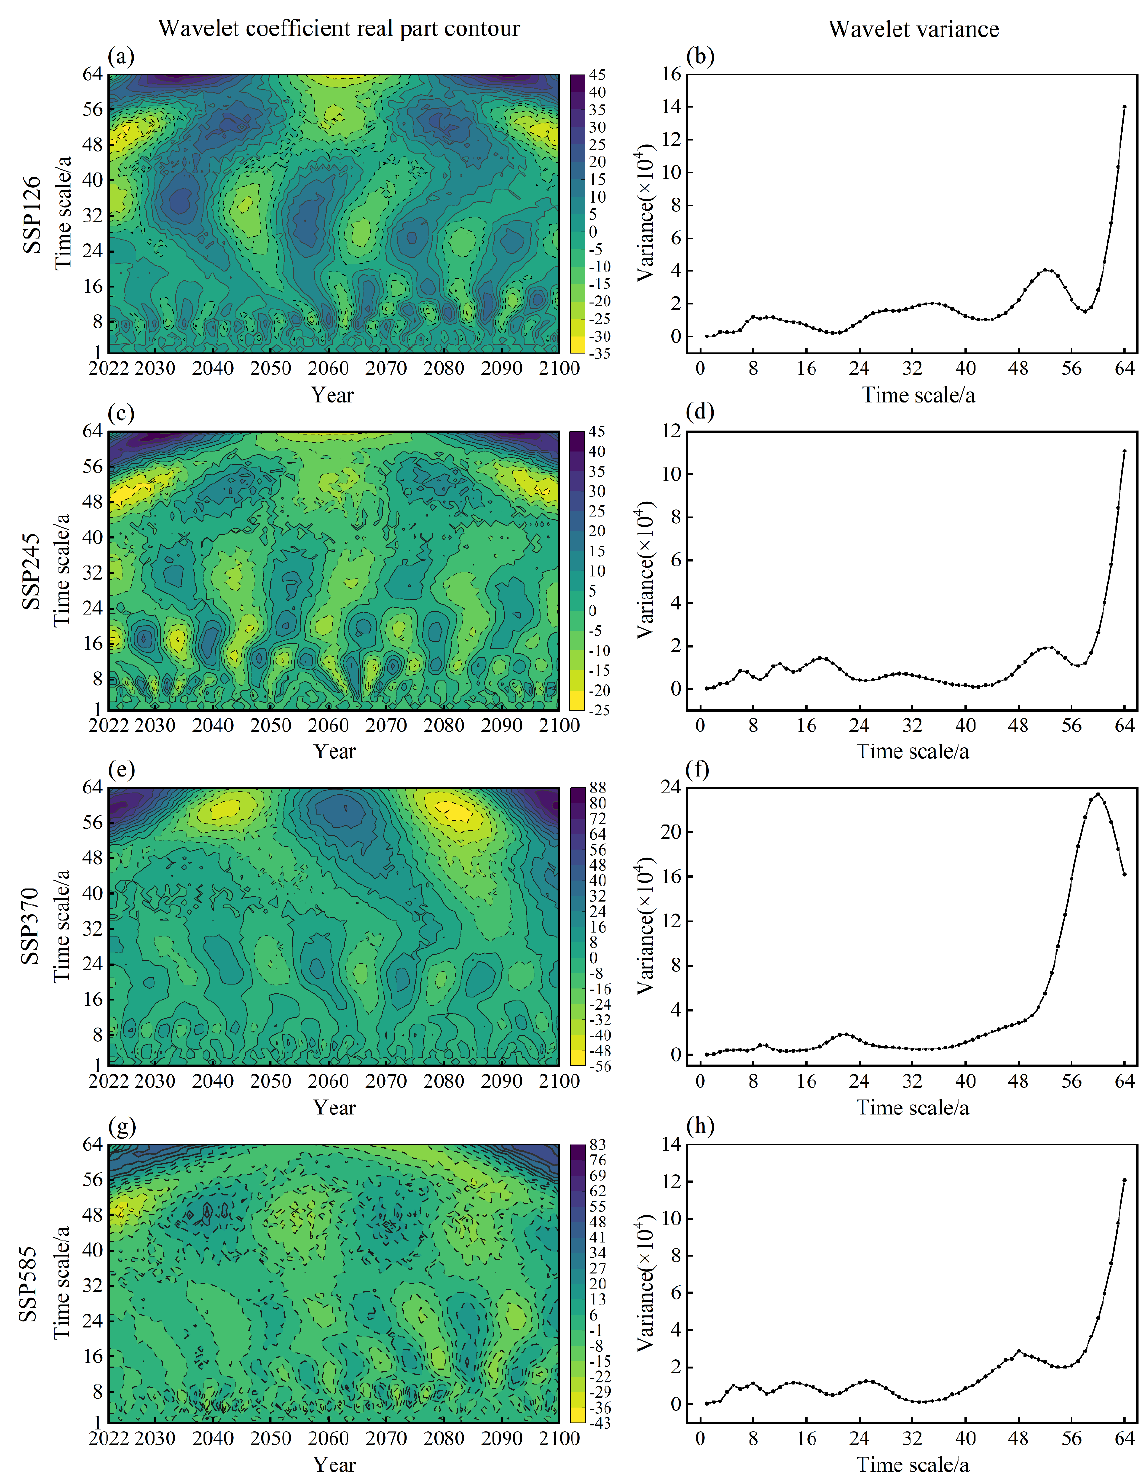
Figure 9. Wavelet analysis of ET 0 in the Yellow River Basin under four future emission scenarios (SSP126, SSP245, SSP370, and SSP585), including wavelet coefficient contour plots of the real part ( a , c , e , g ) and wavelet variance plots ( b , d , f , h ).